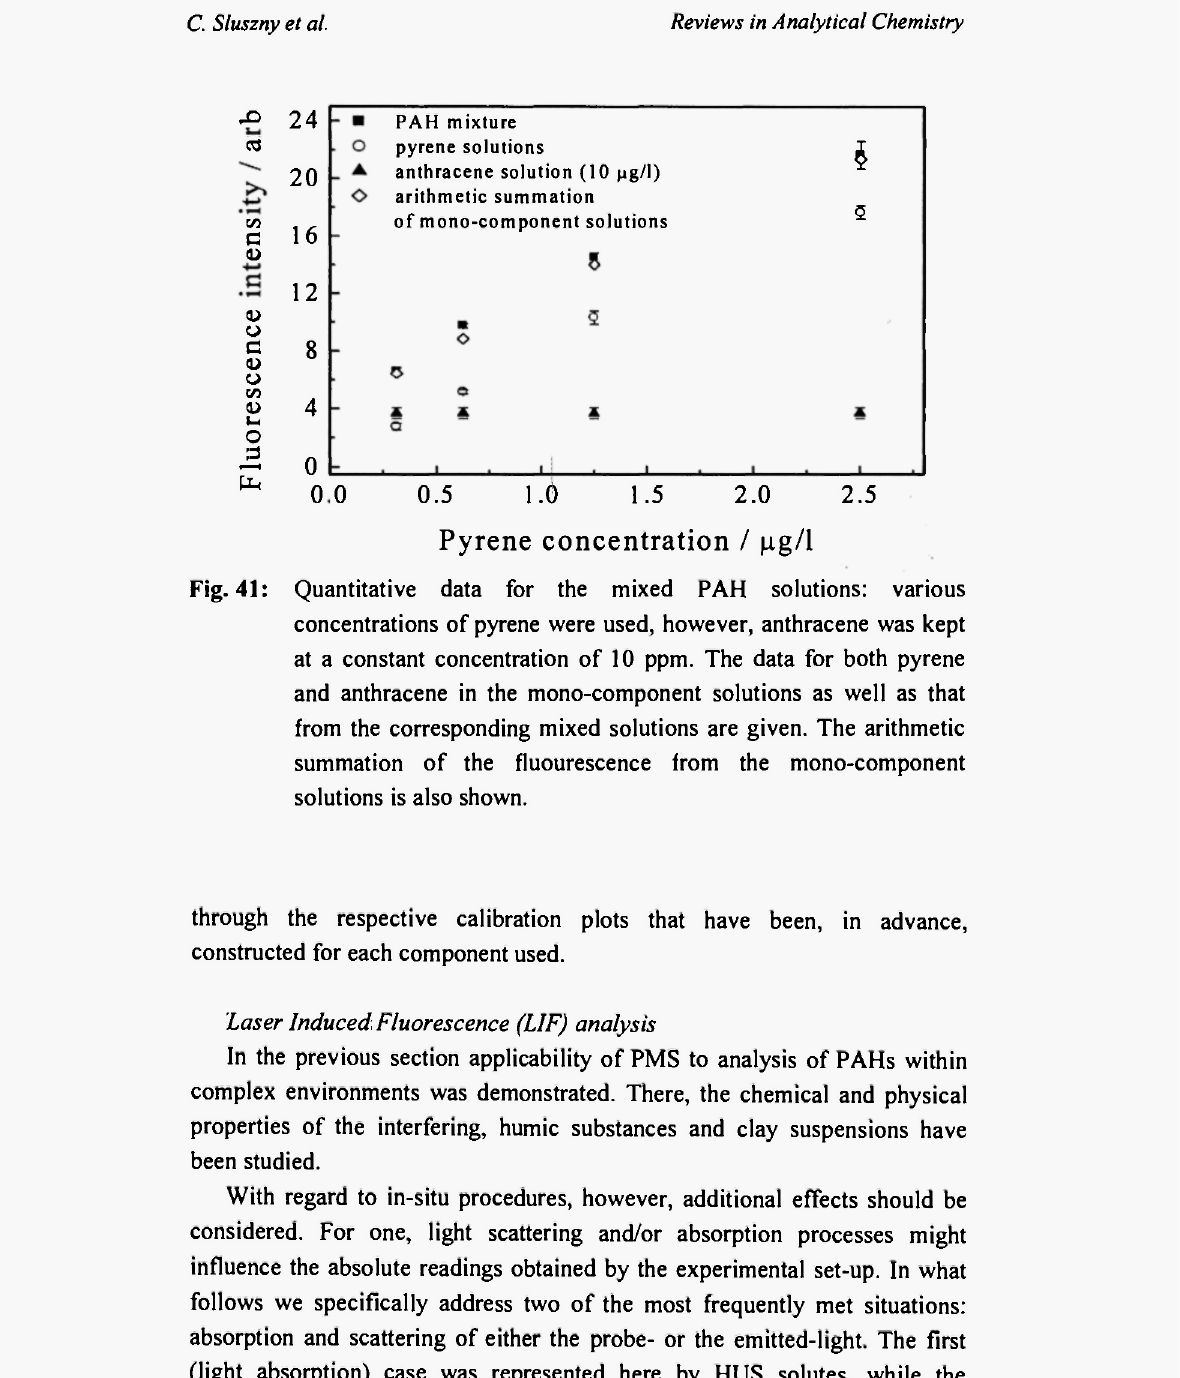
Pyrene concentration / μ§/1 Fig. 41: Quantitative data for the mixed PAH solutions: various concentrations of pyrene were used, however, anthracene was kept at a constant concentration of 10 ppm. The data for both pyrene and anthracene in the mono-component solutions as well as that from the corresponding mixed solutions are given. The arithmetic summation of the fluorescence from the mono-component solutions is also